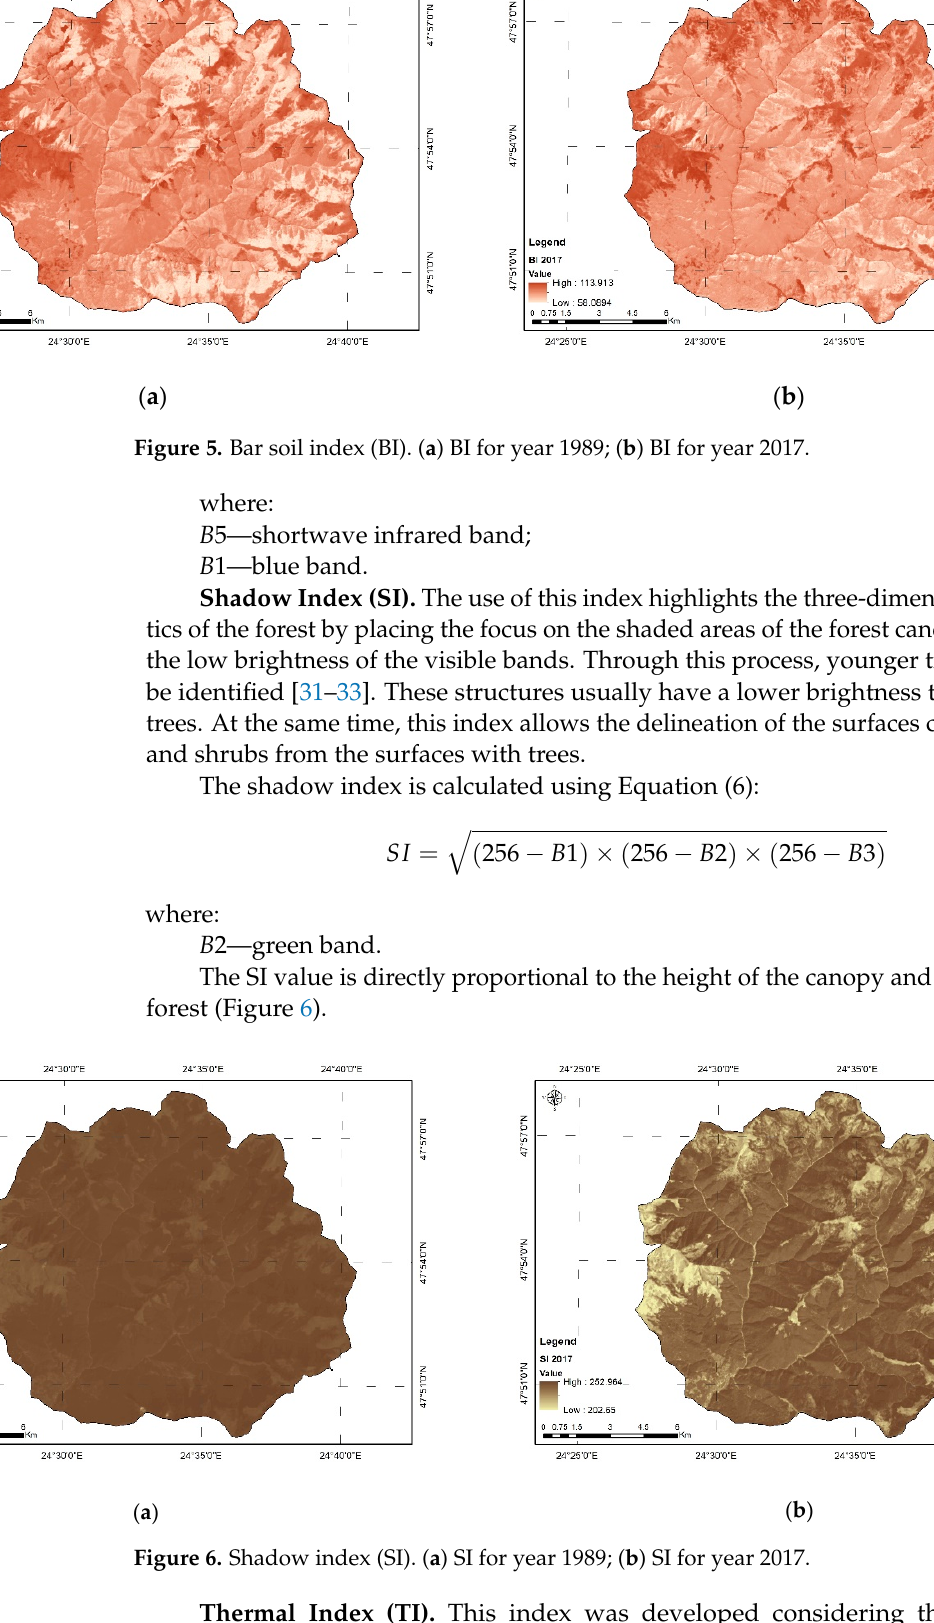
( b ) Figure 4. Advanced vegetation index (AVI). ( a ) AVI 1989, ( b ) AVI 2017. Bare Soil Index (BI) . Adding an index to identify bare soil surfaces, in combination with vegetation indices, results in a stronger contrast in the analysis [31–33]. The basic logic of this approach is to build on the high reciprocity between the state of the bare soil and the state of vegetation. By combining vegetation and bare soil indices in the analysis, one can assess the state of forests on a continuum ranging from high vegetation conditions to exposed soil conditions.